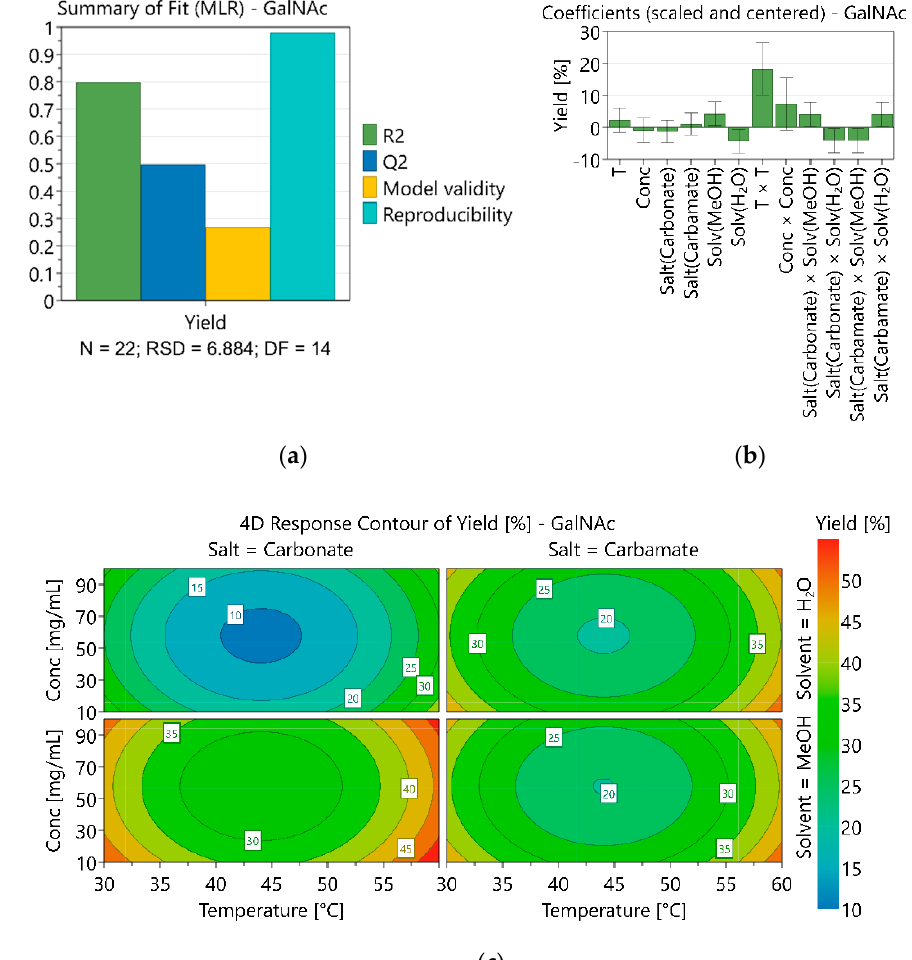
Figure 2. Plots of the model for GalNAc generated by MODDE: ( a ) Summary of fit shows a rather low significance of the model; ( b ) plot of coefficient values for scaled and centered factors shows significant factors according to the model; ( c ) the 4D response contour plot of yield predicts yields of amination in dependence on qualitative and quantitative factors.